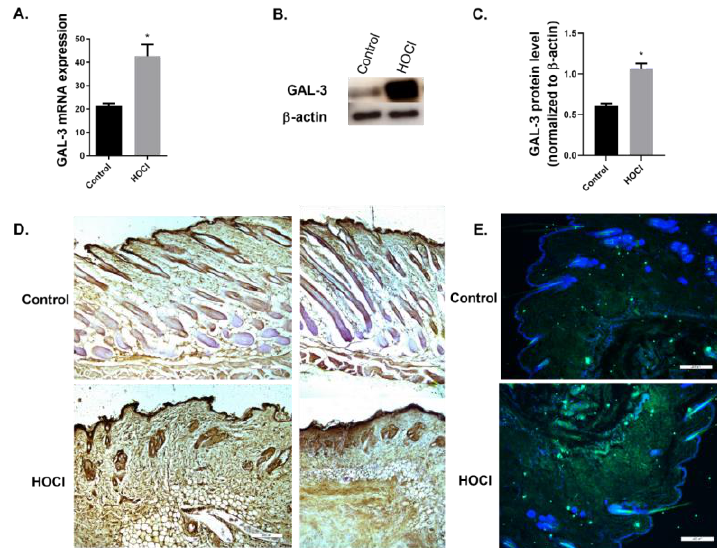
Figure 5. Galectin-3 expression is increased in a skin fibrosis animal model. BALB/c mice were ad- ministered intra-dermal injections of 100 μL hypochlorite (HOCl) daily for 6 weeks. Mice were culled and levels of ( A ) Galectin-3 (GAL-3) messenger RNA in fibrotic skin tissue were assessed by real-time PCR. ( B ) Western blot depicting GAL- 3 or β -actin loading control. ( C ) Densitometry anal- ysis of GAL-3 expression from Western blot. ( D ) Representative immunohistochemistry microscope images of skin sections from control and HOCl for GAL-3 immunostaining. Original magnification: x10; Scale: 200 µm. ( E ) Representative immunofluorescence microscope images of skin sections from control and HOCl for GAL-3 immunostaining. DAPI, blue nuclei. Scale 200 µm. The graphs present representative data from ( A ) one experiment with n = 7 (Control) and n = 8 (HOCl) mice per group, ( B , C ) one experiment with n = 7 (Control) and n = 8 (HOCl) mice per group. Results are presented as mean ± SEM. Statistical analysis was performed by Mann – Whitney test (one-tailed). * p ≤ 0 .05 vs. control.